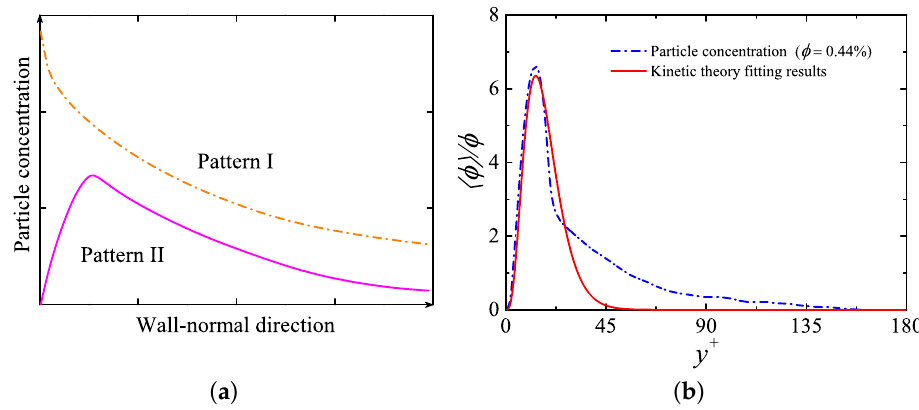
Figure 13. ( a ) Two different patterns of the particle concentration distribution and ( b ) particle concentration profile from case φ = 0.44% versus a fitting curve based on the kinetic